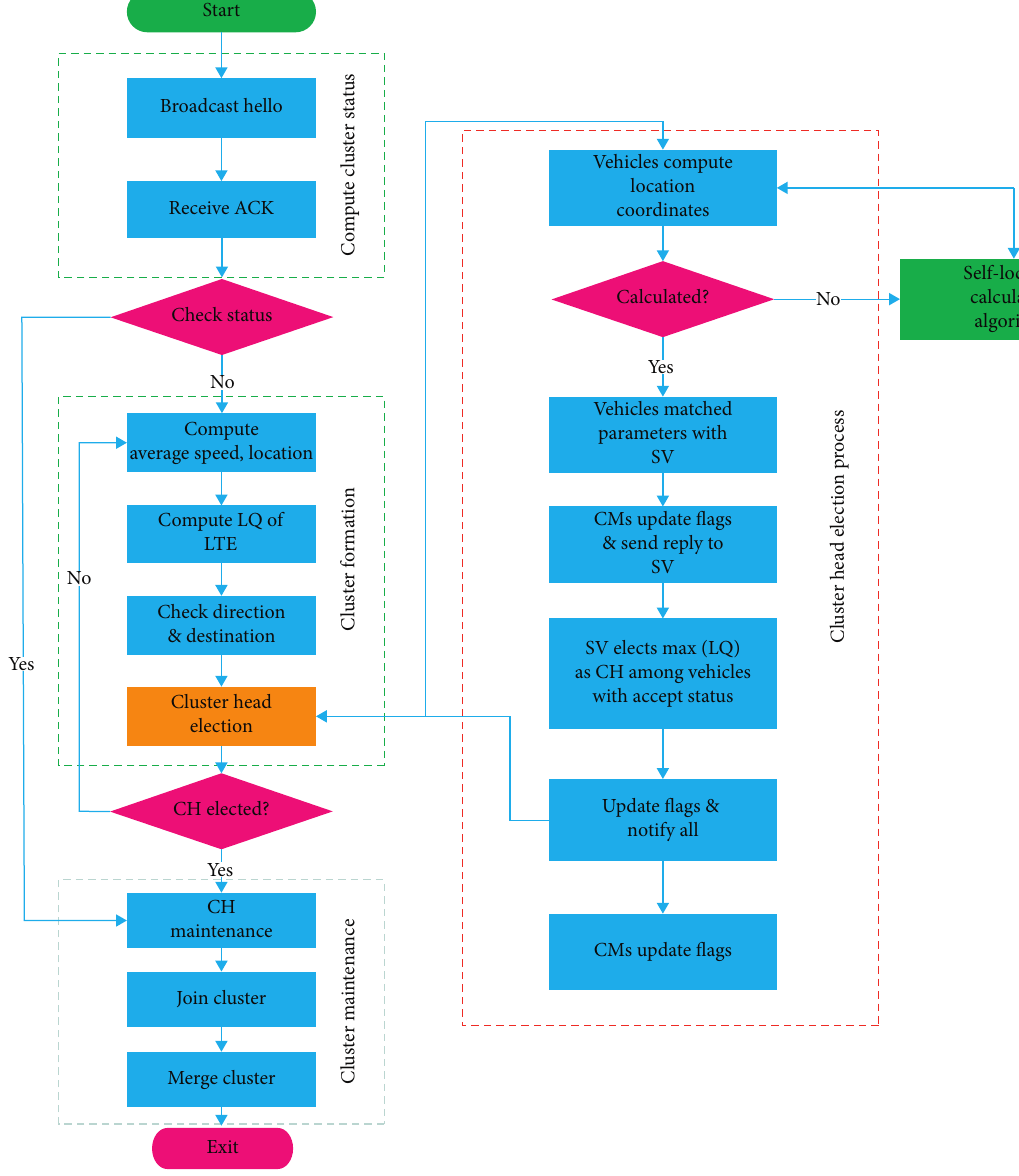
Figure 2: Block diagram of clustering